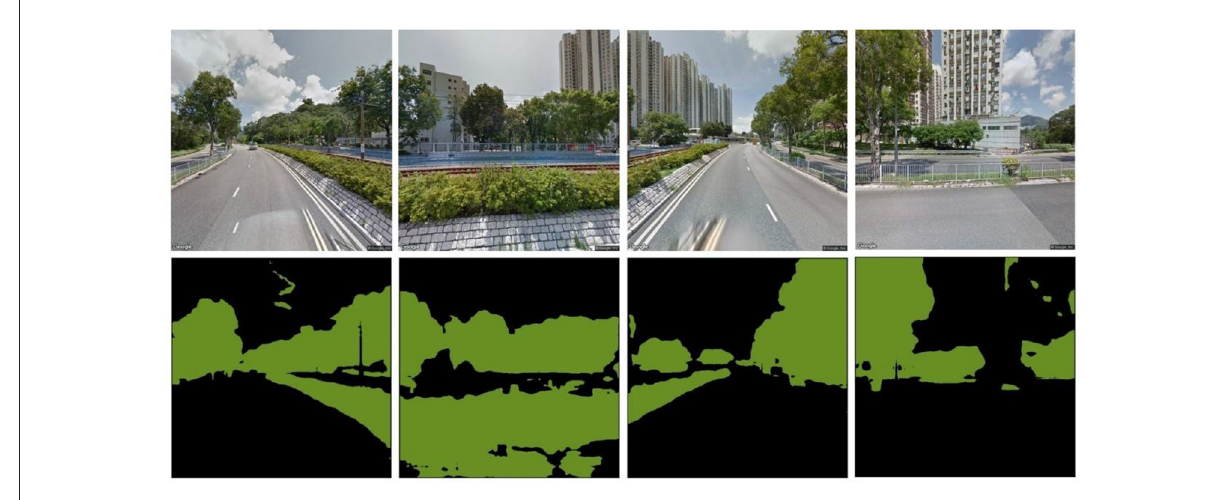
FIGURE3 The estimation of the green view